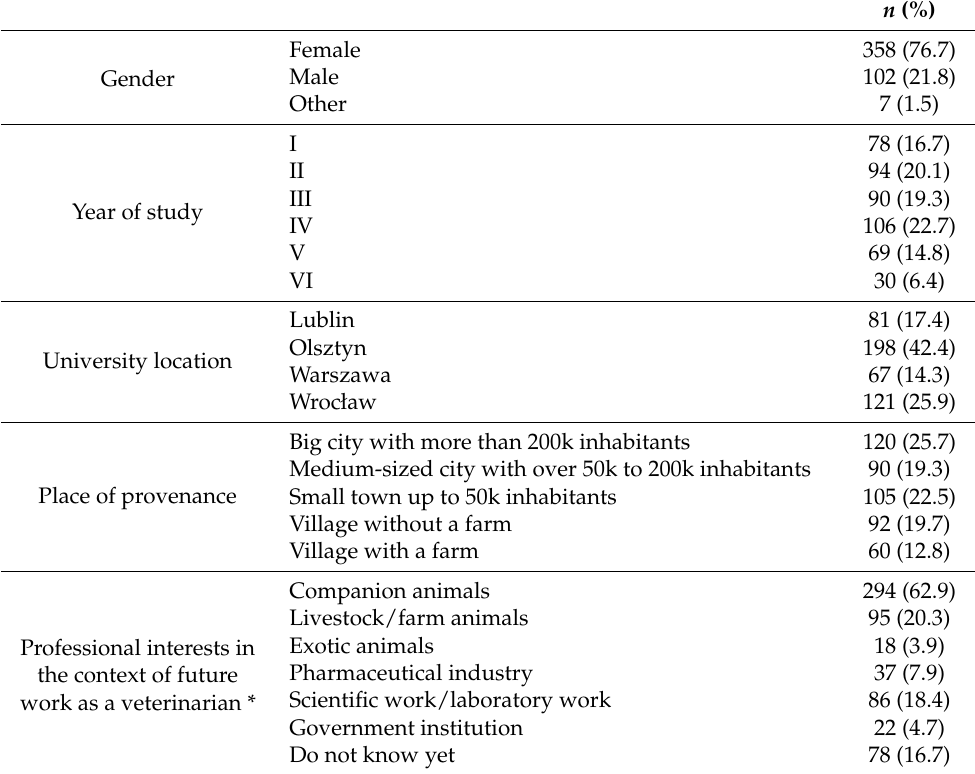
Table 1. Sociodemographic characteristics of study participants ( n =